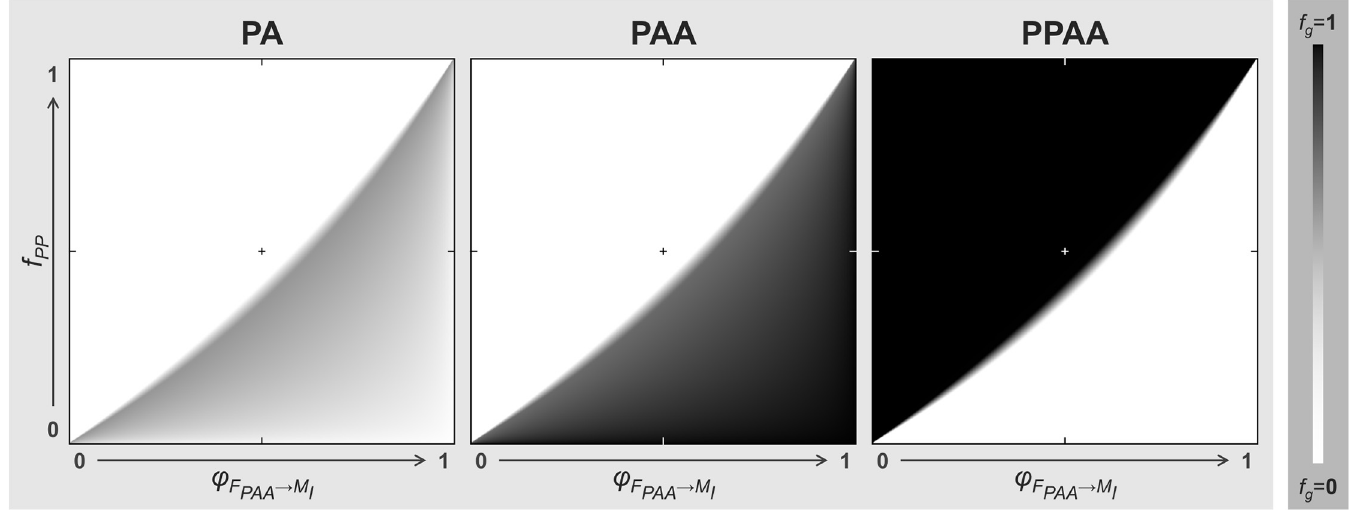
Fig 4. Genomotype frequencies at the equilibria predicted by the model. Relative frequencies of the three S . alburnoides genomotypes (PA, PAA and PPAA) range from f g = 0 (white) to f g = 1 (black) as a function of PAA females ’ preference towards type I males ( φ FPAA ! MI ; Table 1) and of the frequency of the sympatric S . pyrenaicus non-hybrid species ( f PP ). Note that, although a 0 < f PP < 1 range is shown on the y -axis, the model cannot operate on f PP = 1 because it represents a population exclusively constituted by S . pyrenaicus specimens, in which the S . alburnoides ones are absent.